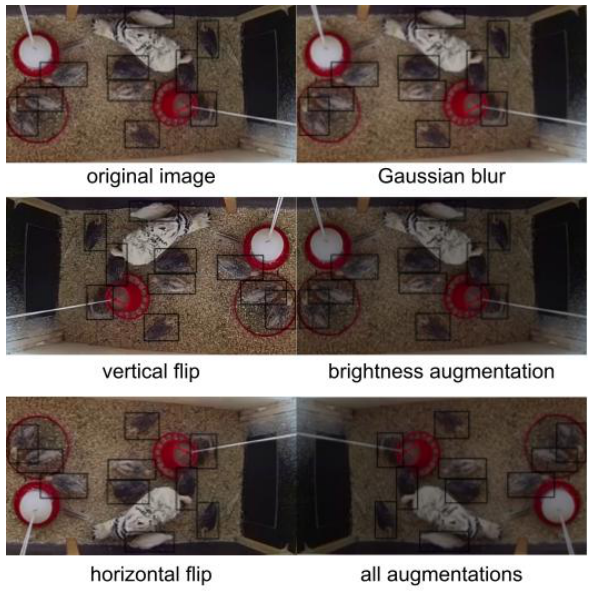
Figure 7. Example of the different augmentation strategies used. Augmentation